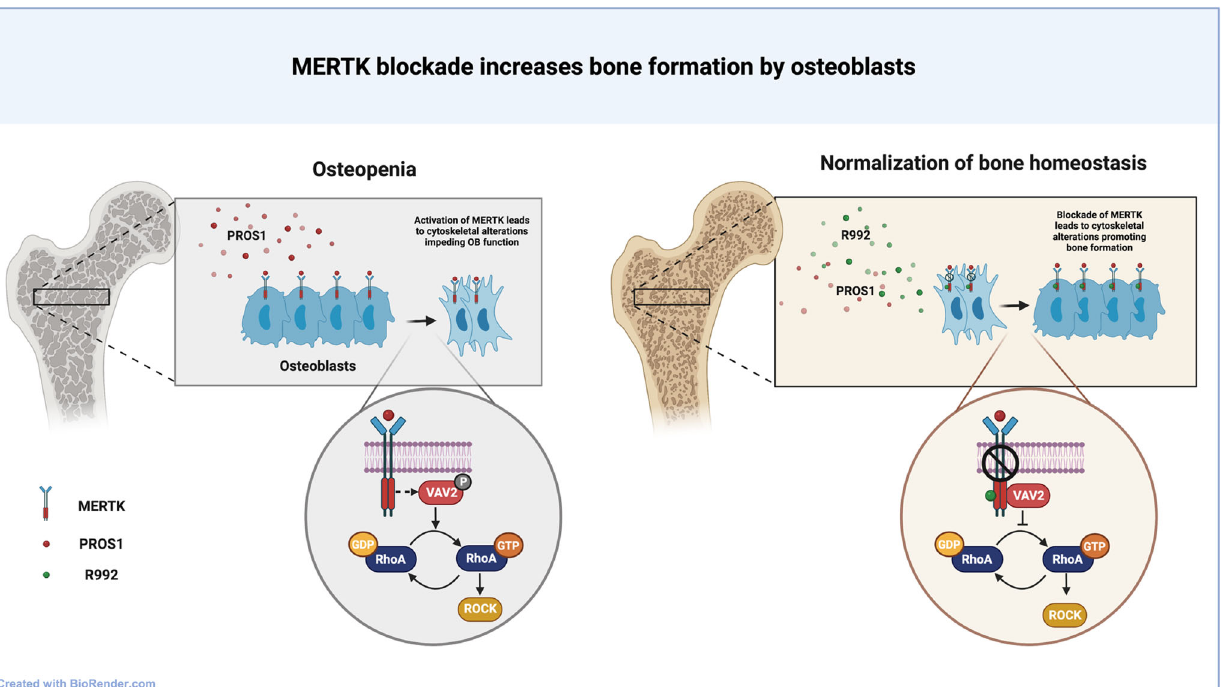
Fig. 8 | Schematic outline of the mechanism showing how the MERTK-PROS1 axis exerts osteopenia via the VAV2-RHOA pathway. Inhibition of this axis led to the normalization of bone homeostasis by increasing osteoblast